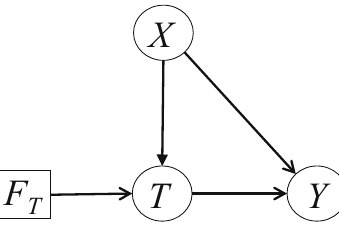
Figure 10: Reduced DAG with su ffi cient covariate X and regime indicator.